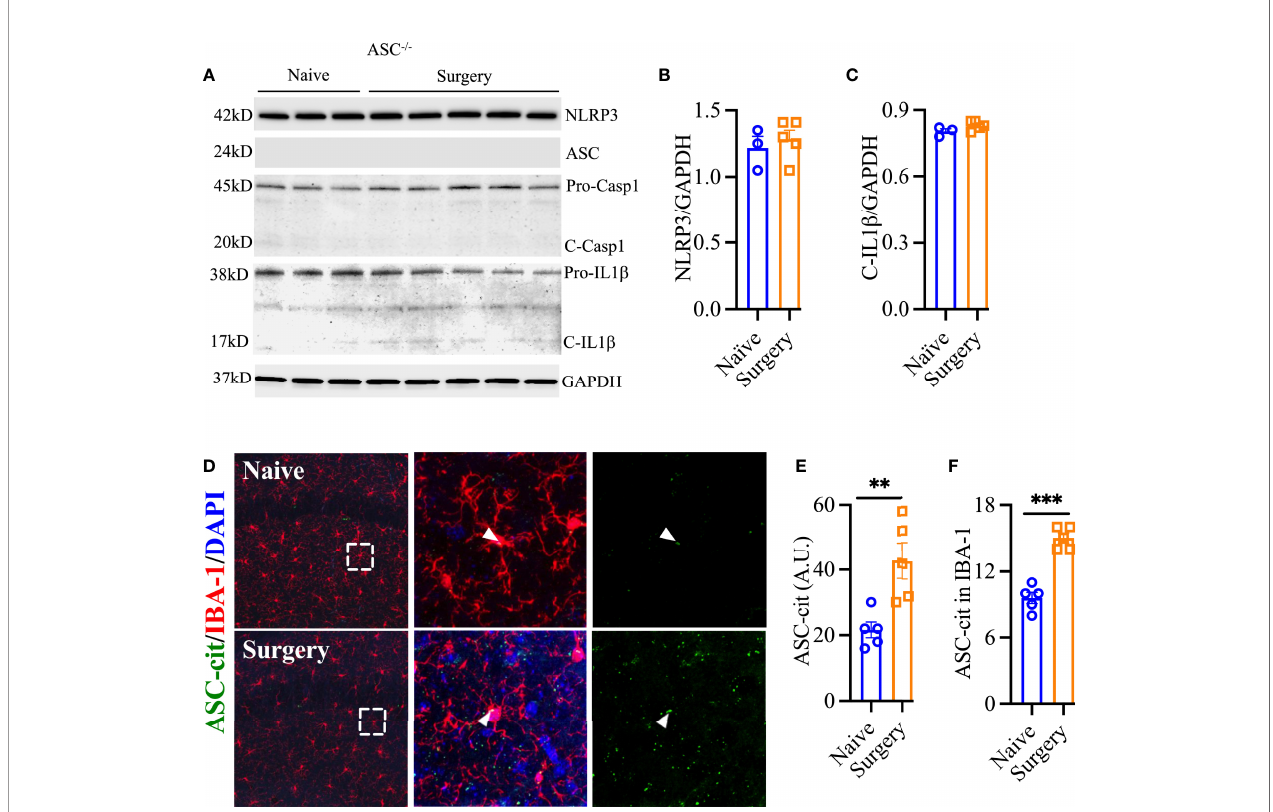
FIGURE 4 | ASC speck formation after surgery. Asc -/- showed no evidence of NLRP3 in fl ammasome activation in hippocampal lysate (A – C) . ASC-cit reporter mice showed signi fi cant speck formation in the hippocampus, including co-expression with IBA-1-positive cells (D – F) . Three representative areas/mice were used for quanti fi cation and one single microglia was represented in the reconstruction (red indicates fi lament tracing) from hippocampal CA1 area. Age matched WT controls are described in Figures 1 and 2 . Data are presented as mean ± SEM. n = 3-5/group. ** P < 0.01, *** P < 0.001; analyzed by two-tailed unpaired Student ’ s t test. Scale bar: 20 m m. Representative data are from one